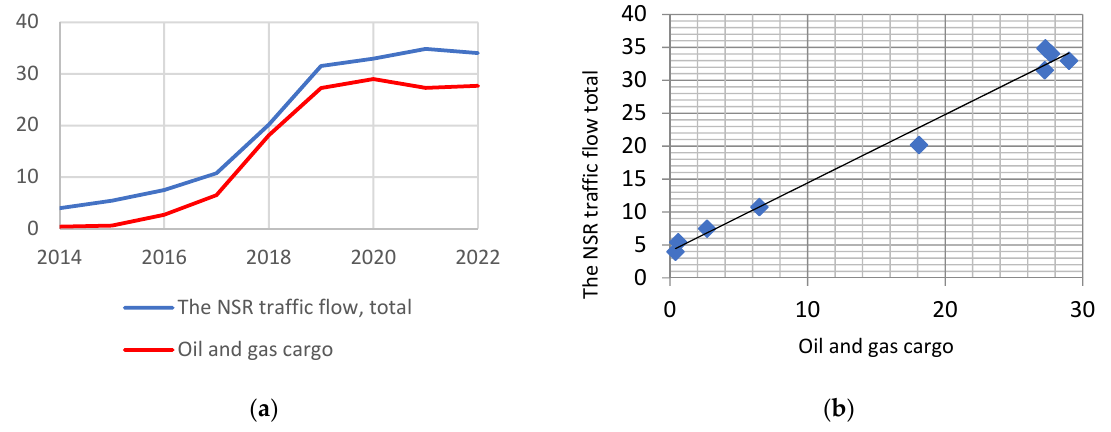
Figure 5. Volumes of oil and gas cargo transportation along the NSR in 2014–2022, mln t. ( a ) Factual data; ( b ) Correlation field. Source: compiled by the author according to the data of [6,38,44,57,58].